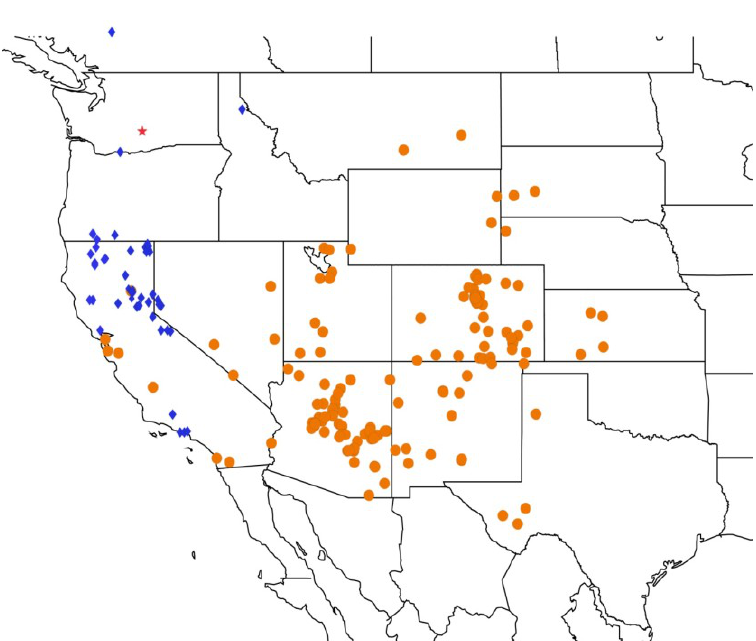
Figure 54. Distribution of Okanagana yakimaensis (red star), O. ornata (blue diamonds) and O. hesperia (orange